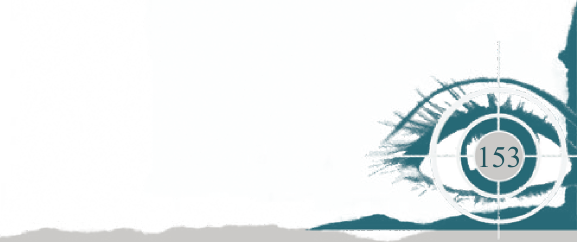
Figure 1 An optical axis O and entrance T 0 and exit T planes of an even-catadioptric system. A ray with incident segment R 0 on O has emergent segment R also on O, with the two segments pointing in the same direction. The system itself is not shown; it may extend upstream from T 0 and downstream from